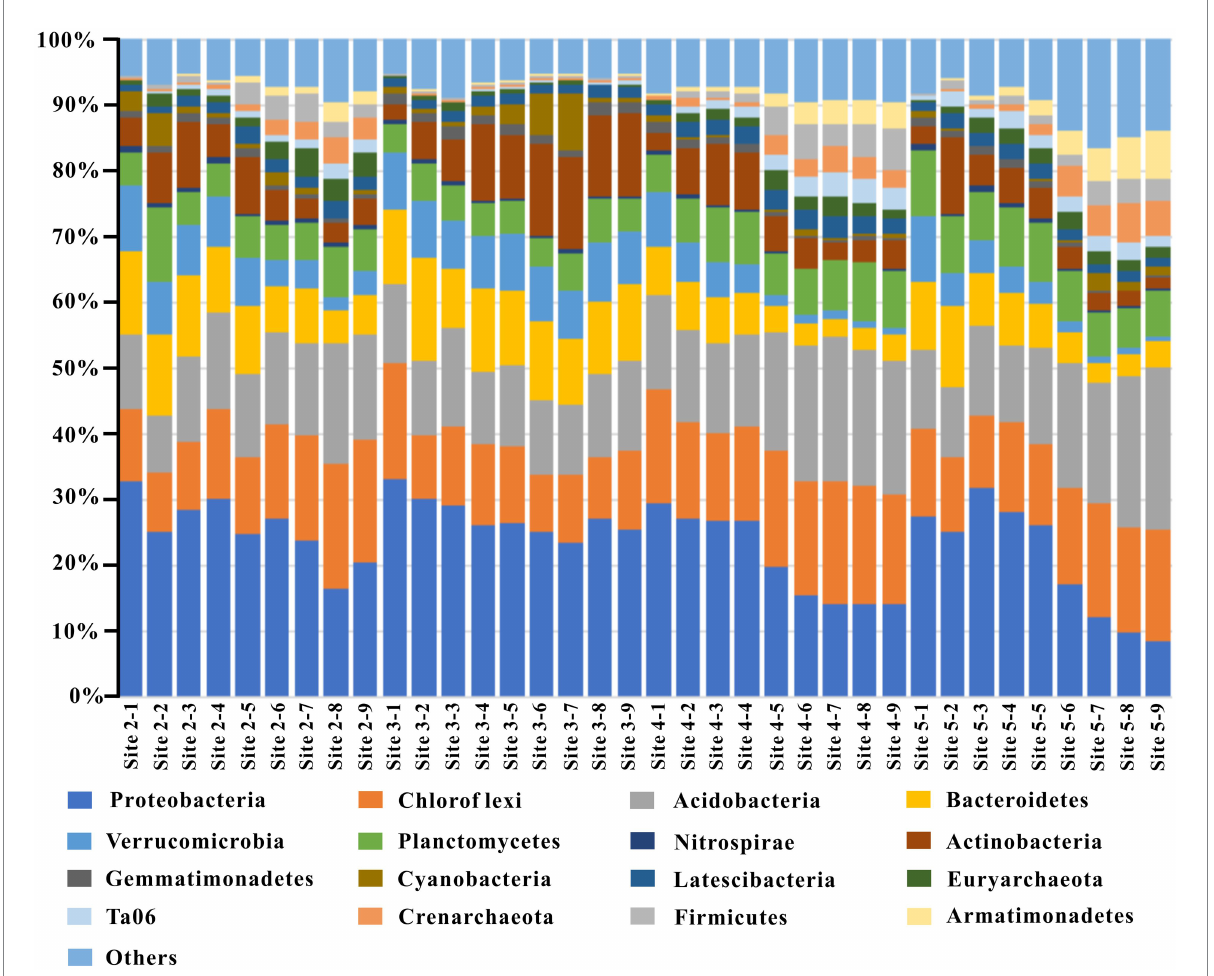
FIGURE 3 The top ten phyla at each sediment